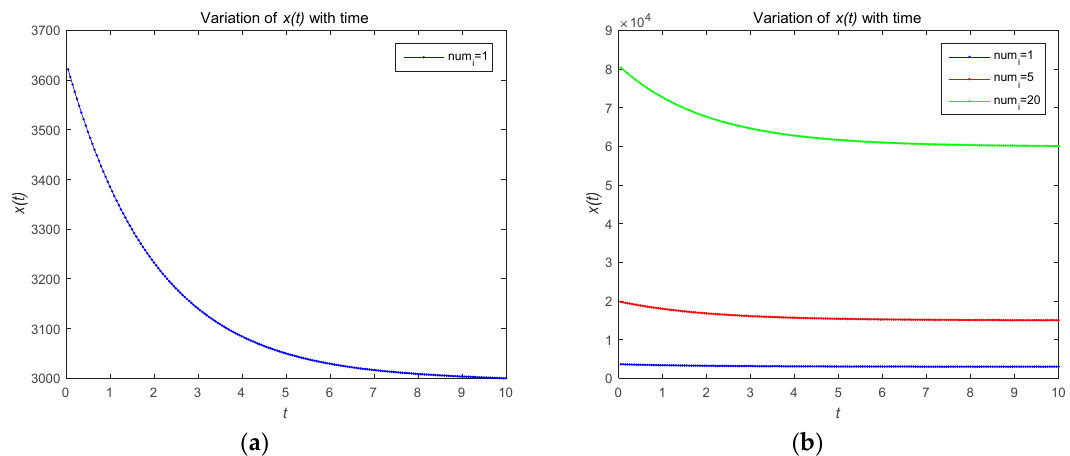
Figure 3. ( a ) Risk level variation for a system with one attacker; ( b ) risk level variation for a system with different numbers of attackers.